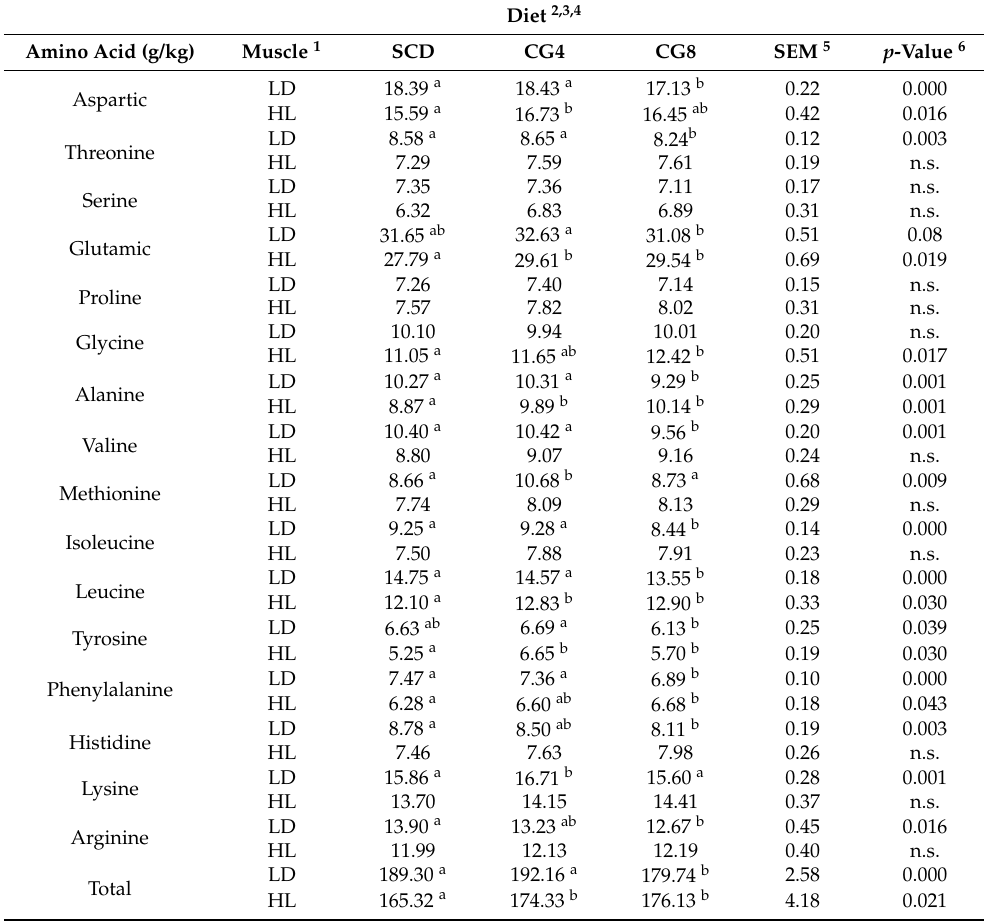
Table 3. Impact of freshwater C. glomerata biomass inclusion in the diet of rabbits on the amino acid profile of different rabbit